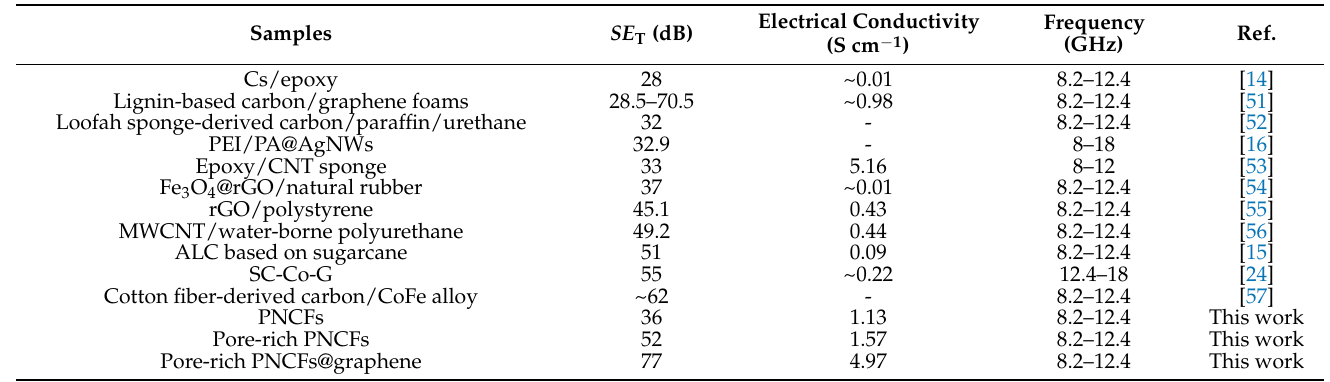
Table 2. Recently reported SE T value of some biomass-based EMI shielding